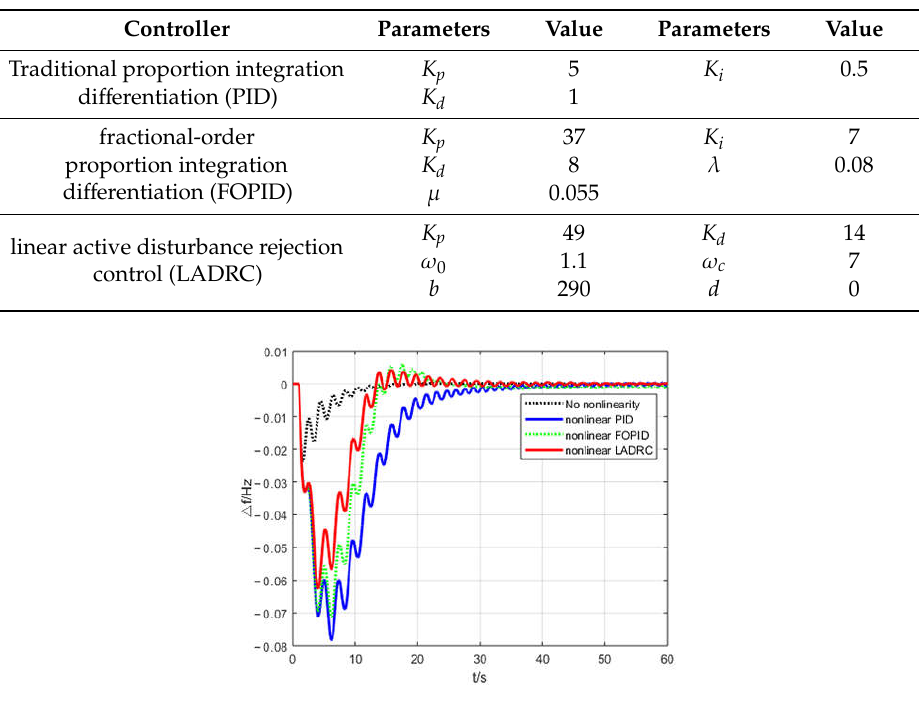
Figure 6. Frequency variation chart of the disturbance zone under different controllers.